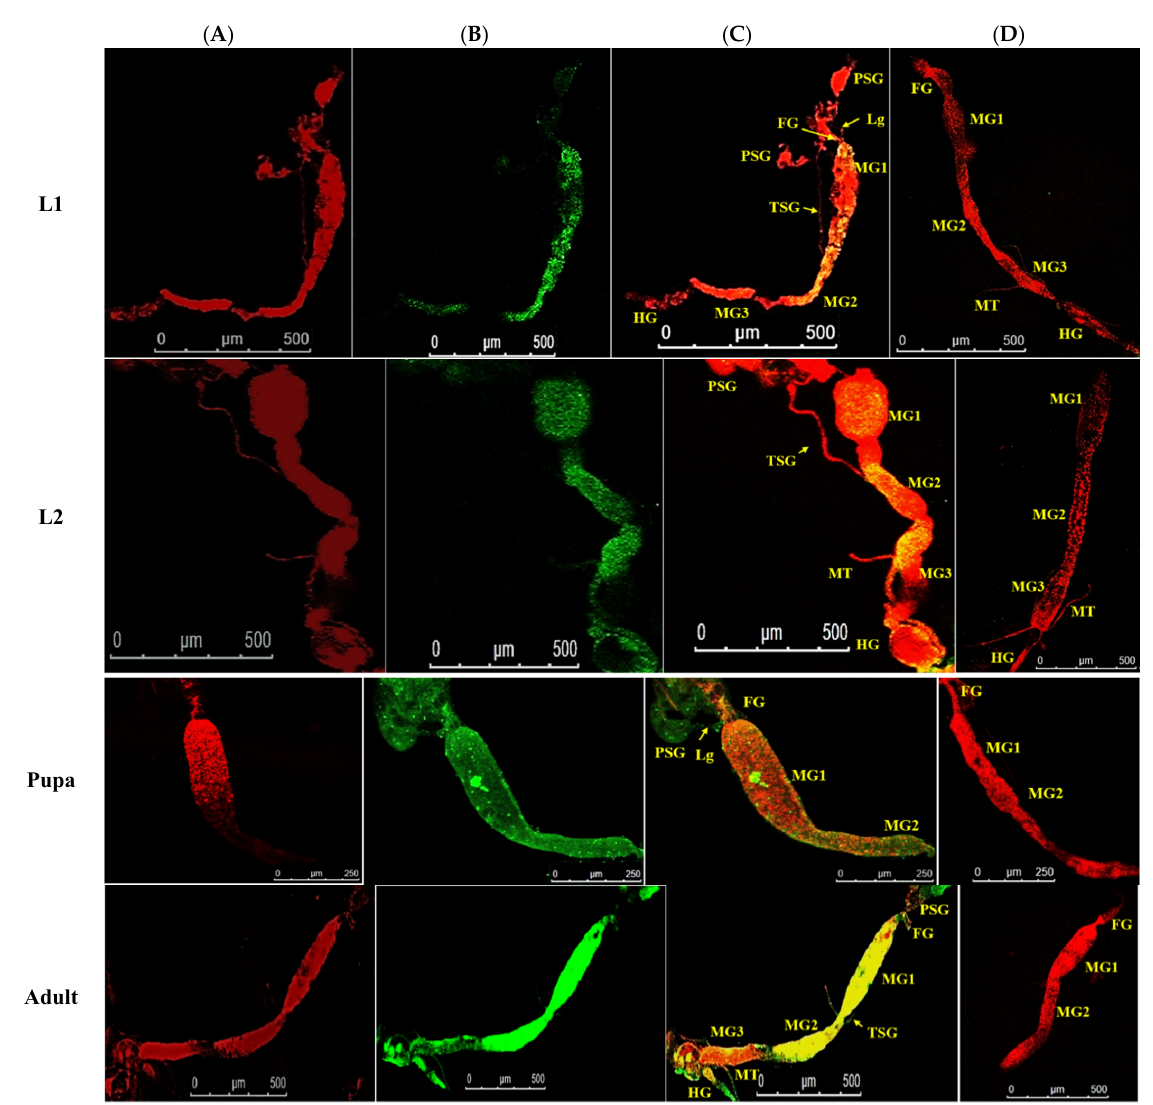
Figure 3. Localization of WBNV N protein in different life stages of Thrips palmi . Larval (L1, L2), pupal and adult stages of WBNV-exposed and non-exposed T. palmi were dissected. The specimens were labeled with Alexa Fluor 594 phalloidin, and rabbit antibodies against WBNV N protein followed by FITC-conjugated goat anti-rabbit antibody. Alexa Fluor 594- and FITC-specific fluorescence signals were captured by confocal microscopy. ( A ). Alexa Fluor 594 phalloidin-conjugated F-actin probe emitted red fluorescence ( B ). FITC-conjugated goat anti-rabbit antibody emitted green fluorescence indicating the presence of WBNV N protein in WBNV-exposed T. palmi ( C ). Merging both Alexa Fluor 594 and FITC signals yielded yellow-orange shades in parts of the image where both red and green fluorescence were emitted ( D ). Merged Alexa Fluor 594 and FITC-specific fluorescence signals in non-exposed T. palmi indicating absence of WBNV. Specimens belonging to different life stages of T. palmi are indicated on the left. FG—foregut; MG1—midgut 1; MG2—midgut 2; MG3—midgut 3; HG—hindgut; PSG—principal salivary gland; TSG—tubular salivary gland; Lg—ligament; MT—Malpighian tubules. In L1, the infection of WBNV was indicated by presence of green fluorescence in the anterior midgut 8 h post acquisition. A low intensity green fluorescence was also recorded in PSG and ligaments connecting gut to PSG. However, TSG was not infected by WBNV, indicated by the absence of the green fluorescence signal. Infection of WBNV spread to other parts of the alimentary canal during L2 48 h post acquisition. Multiplication of WBNV in PSG and anterior midgut during pupal and adult stages was evident from an increased level of N protein green